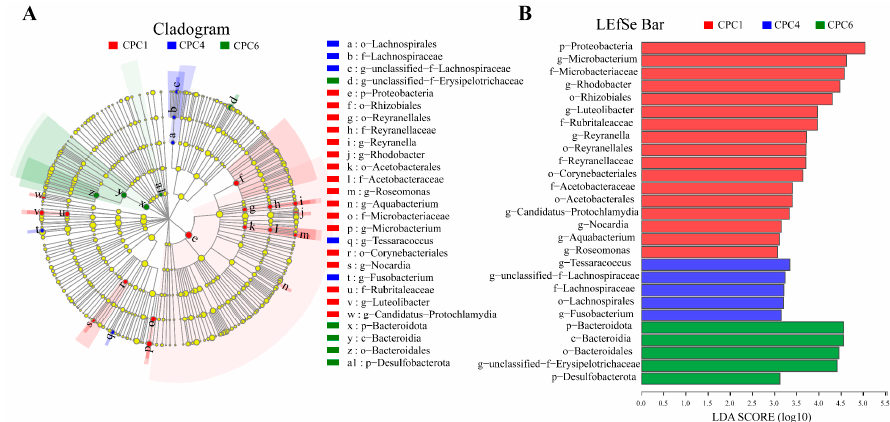
Figure 11. LEfSe analysis identified differential distributions of intestinal microbes among treatment groups with different dietary protein levels. ( A ) Cladogram showing the phylogenetic dis- tribution of intestinal microbes for graded dietary protein level groups generated by LEfSe analysis (layers of the cladogram represent different levels, phyla, classes, orders, families, and genera from the inside out). ( B ) LDA scores showed bacterial differential expression between treatment groups with different dietary protein levels (LDA > 3.0, p < 0.05). The predicted results of intestinal microbiota function are presented in Figure 12. KEGG level 1 showed that the three treatments were mainly enriched for metabolism and environmental information processing (Figure 12A). The top three functions predicted by KEGG level 2 (Figure 12B) were carbohydrate metabolism, amino acid metabolism, and membrane transport. However, significant differences were detected only between CPC1 and CPC6 in the predicted pathways of KEGG level 3 in two pathways, ko00480 (Gluta- thione metabolism) and ko00620 (Pyruvate metabolism) ( p < 0.05), respectively (Figure 12C-H).